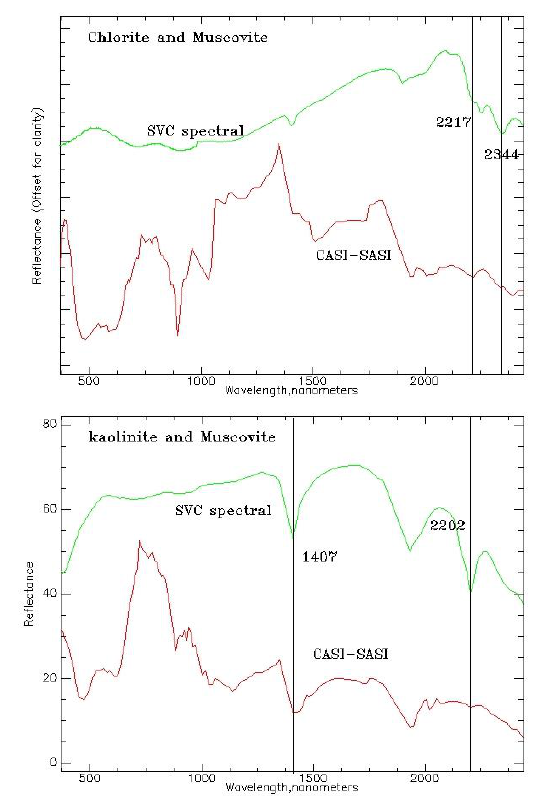
Figure 7. Comparison between CASI_SASI spectral feature and SVC spectral feature